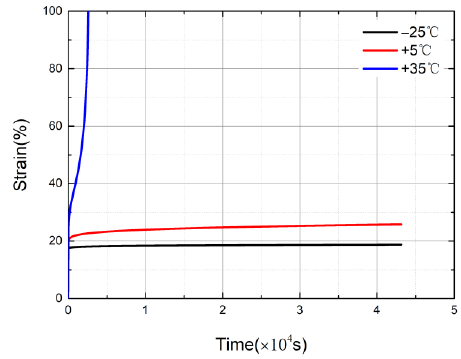
Figure 8. Creep curves at different temperatures under a loaded stress level of 15 MPa. Figure 7 indicates the data curves under different loading stress levels at T = − 25 °C, T = +5 °C, and T = +35 °C. First, the specimens necked after about 3 h when they were loaded with 35 MPa at T = − 25 °C; the specimens necked after about 2 h when they were loaded with 23 MPa at T = +5 °C; and the specimens necked after about 0.7 h when they were loaded with 15 MPa at T = +35 °C. Thus, the specimens stayed in the stable creep stage for a very short time and entered the accelerated creep stage when they were loaded with stress closed to the ultimate strength of this temperature. The strain in ‐ creased rapidly and the specimens shrank at that moment. Second, by comparing the curves that loaded different stress levels at the same temperature, the results indicate that the higher the stress levels of the specimens loaded, the longer the duration and the larger the strain in the initial stage. In contrast, the lower the stress levels of the speci ‐ mens loaded, the faster the specimens entered the stable creep stage and the smaller the slopes of the curves in the stable creep stage, so the specimens remained longer in the stable creep phase. Third, from the three sets of time–strain curves at different tempera ‐ tures, it can be found that when the stress levels of loading are below a certain value, the slopes of the curves in the stable creep stage is very small, so that the specimens remain longer in the stable creep stage. In contrast, the specimens will reach the accelerated creep state in a short time and neck. According to the curves, it can be preliminarily identified that the critical value [25] is 60% of the ultimate strength at a given tempera ‐ ture.